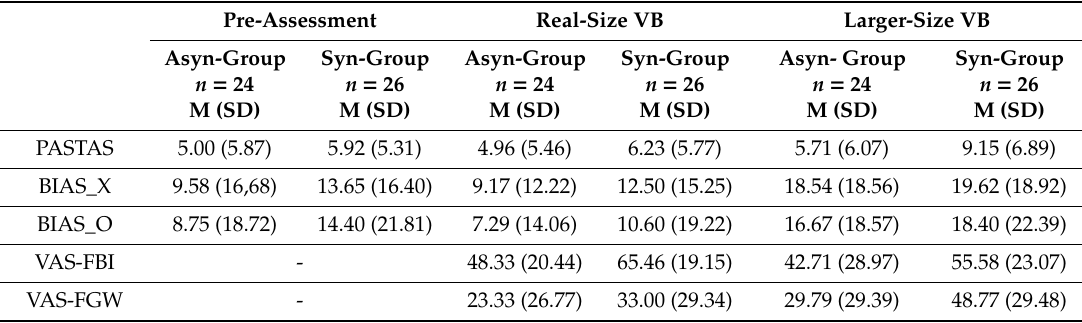
Table 1. Descriptive outcomes, means, and standard deviations stated in the visuo-tactile group condition (asynchronous group versus synchronous group) at the di ff erent assessment conditions.